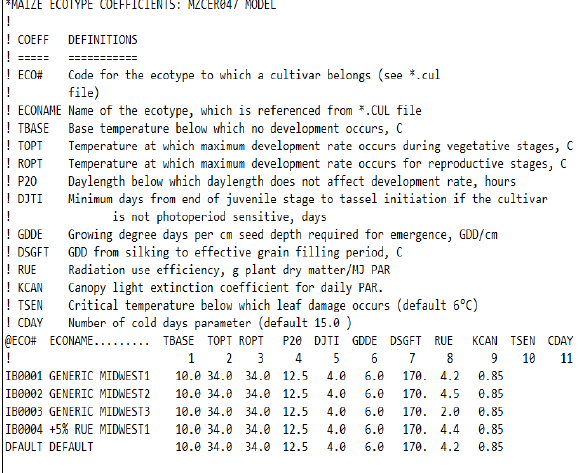
Figure 8. Ecotype data in DSSAT format